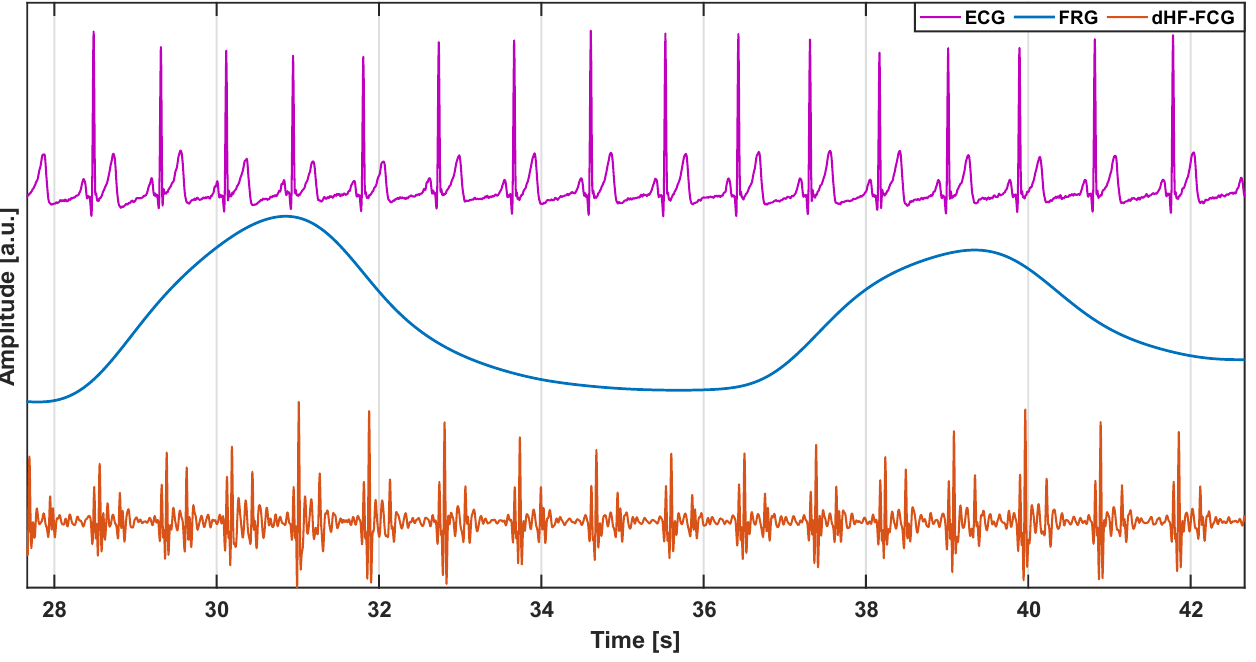
Figure 2. Example of FRG (blue line), dHF-FCG (orange line), and ECG (purple line) signals. The FRG signal captures the expansion and relaxation of the thorax during breathing and allows the accurate monitoring of respiration. The dHF-FCG is a high-frequency component of the FCG signal, which is very similar to the seismocardiogram and provides information about the mechanical function of the heart. The ECG is a well-established signal that provides information about the electrical function of the heart.